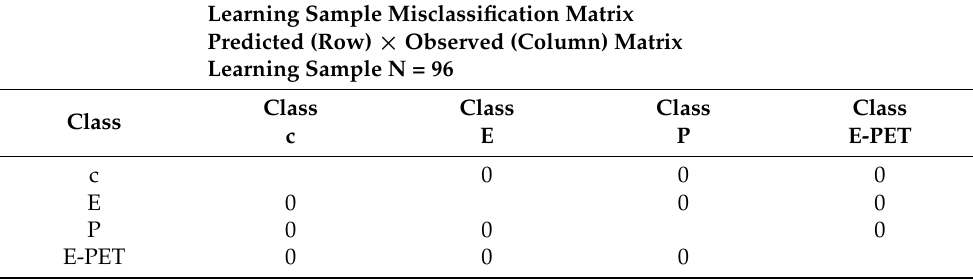
Table 9. Results of incorrect classifications for the training sample.